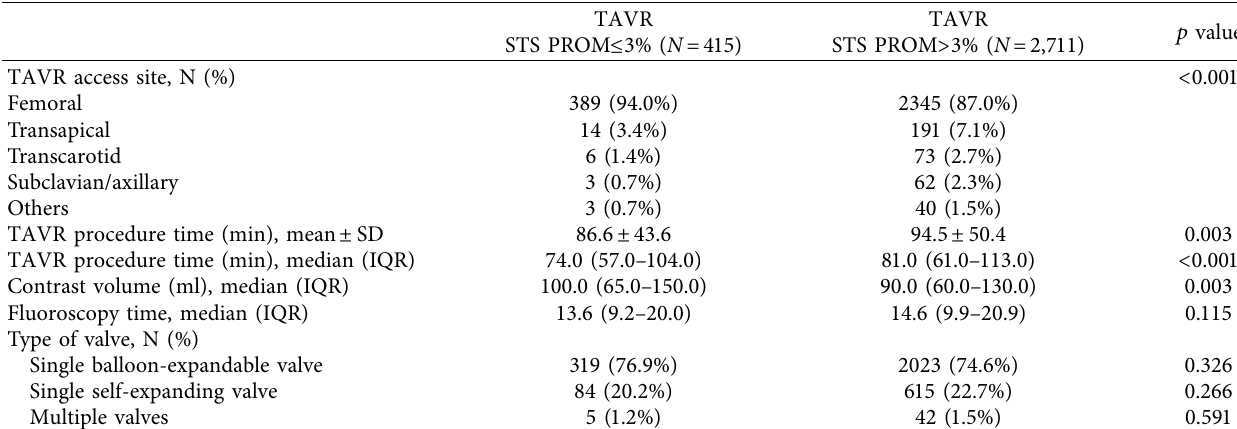
Table 3: Procedure information of TAVR